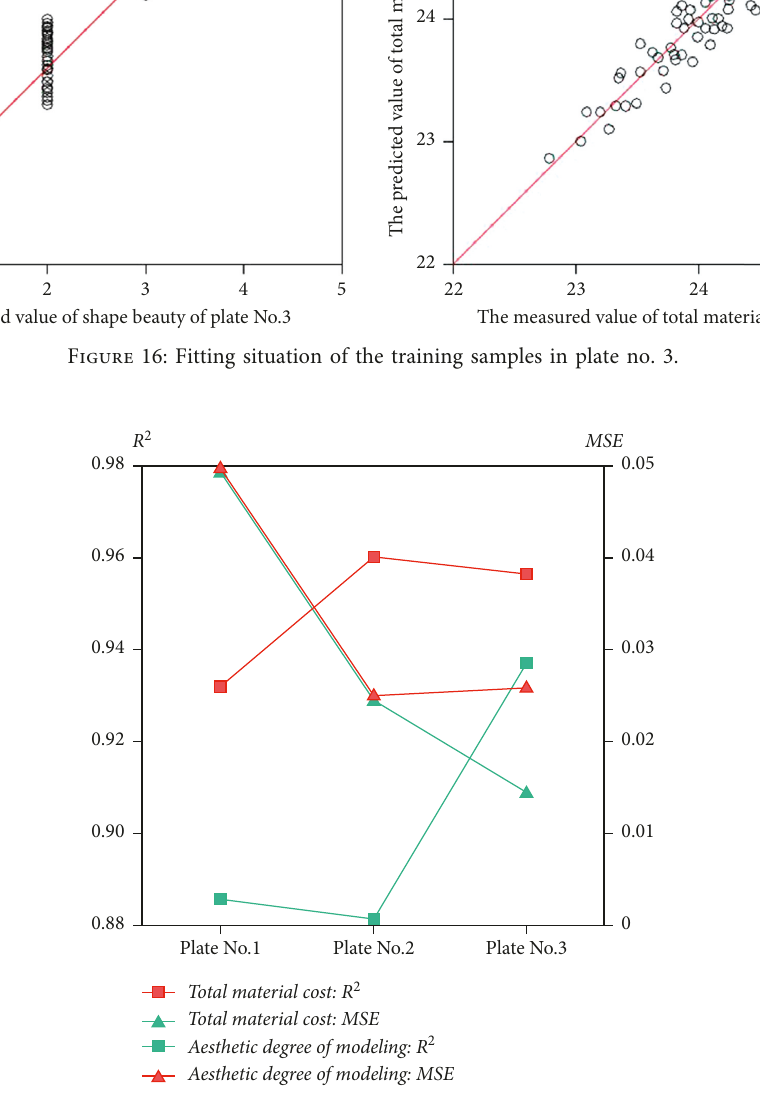
Figure 17: Comparison between the mean square error and sample regression value of the BP neural network in each